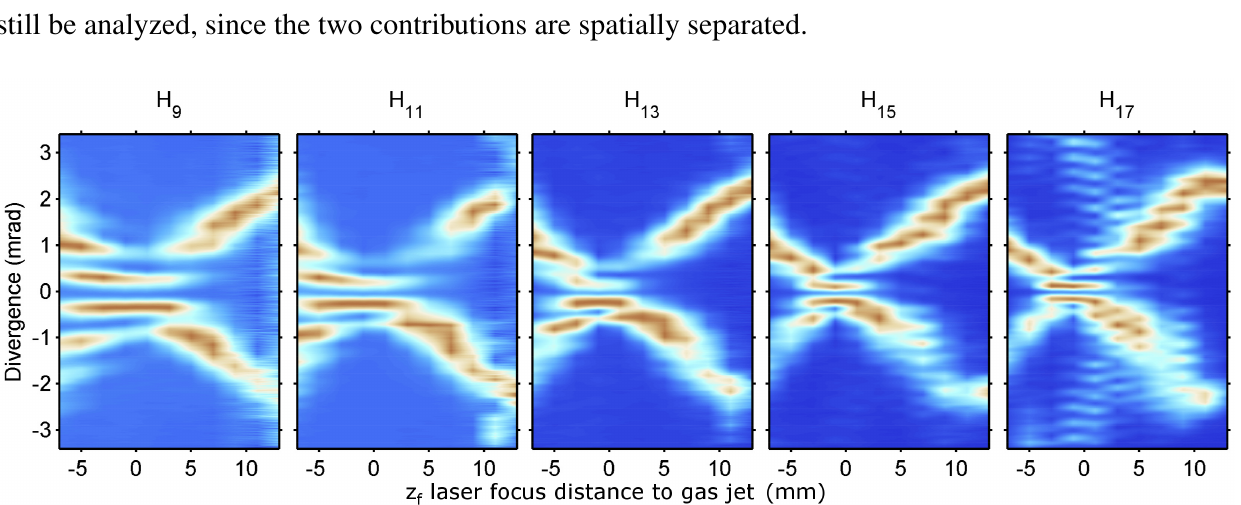
to H of the Aurore laser at 9 17